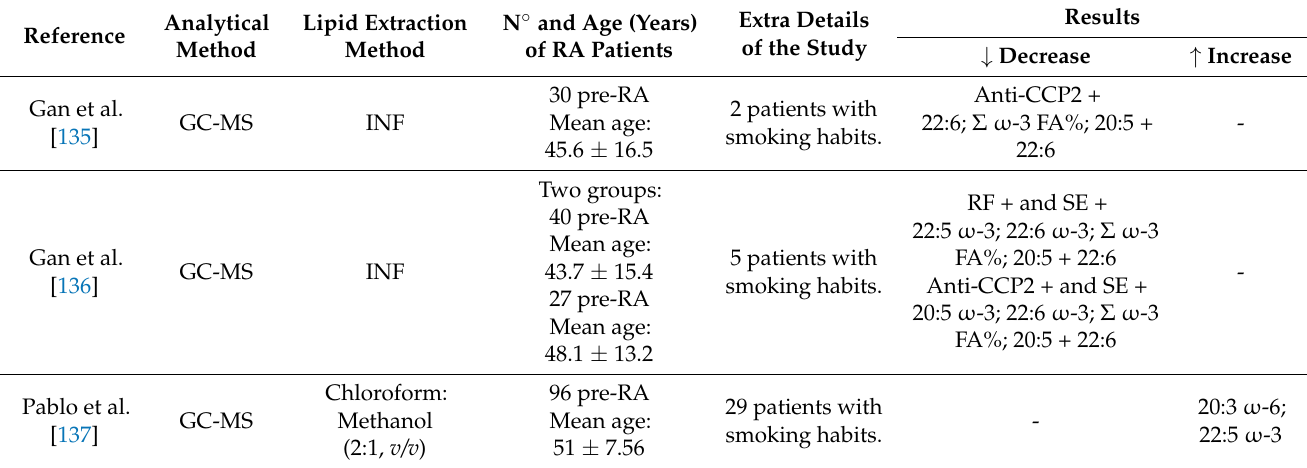
Table 3. Main lipid variations observed in erythrocytes from subjects with high risk of developing RA reported in published lipidomic studies, available in PubMed database, using MS approaches.